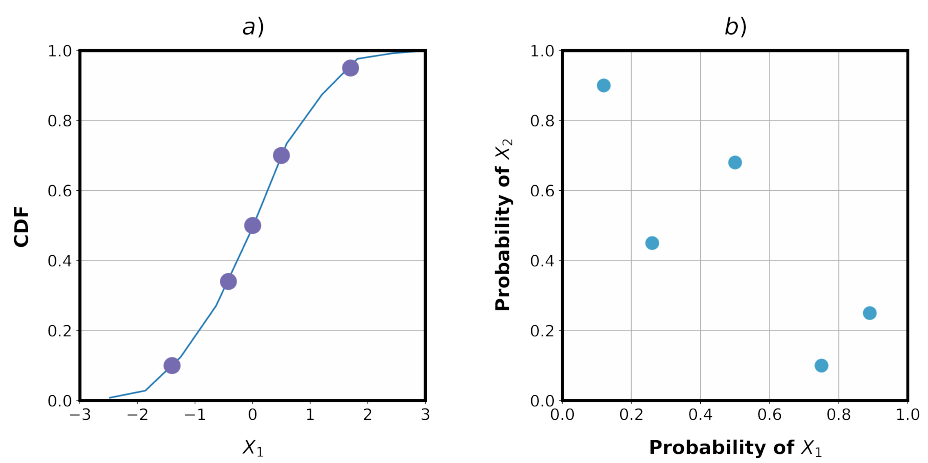
Figure 2. A example of Stratified Sampling and Latin Square Sampling [34]. ( a ) Stratified Sampling. ( b ) The Latin Square Sampling. Table 1. Experiment of Design: the Range of searched